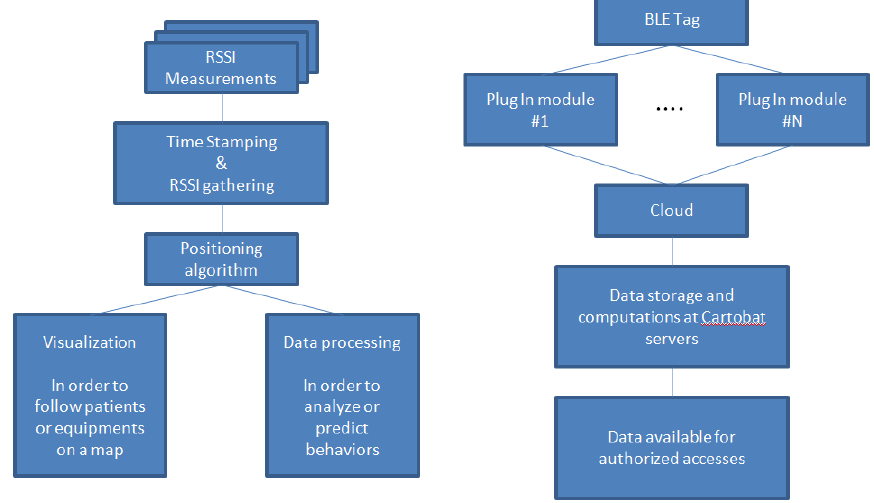
Figure 3. System model diagram ( left ) and System flow chart ( right ).